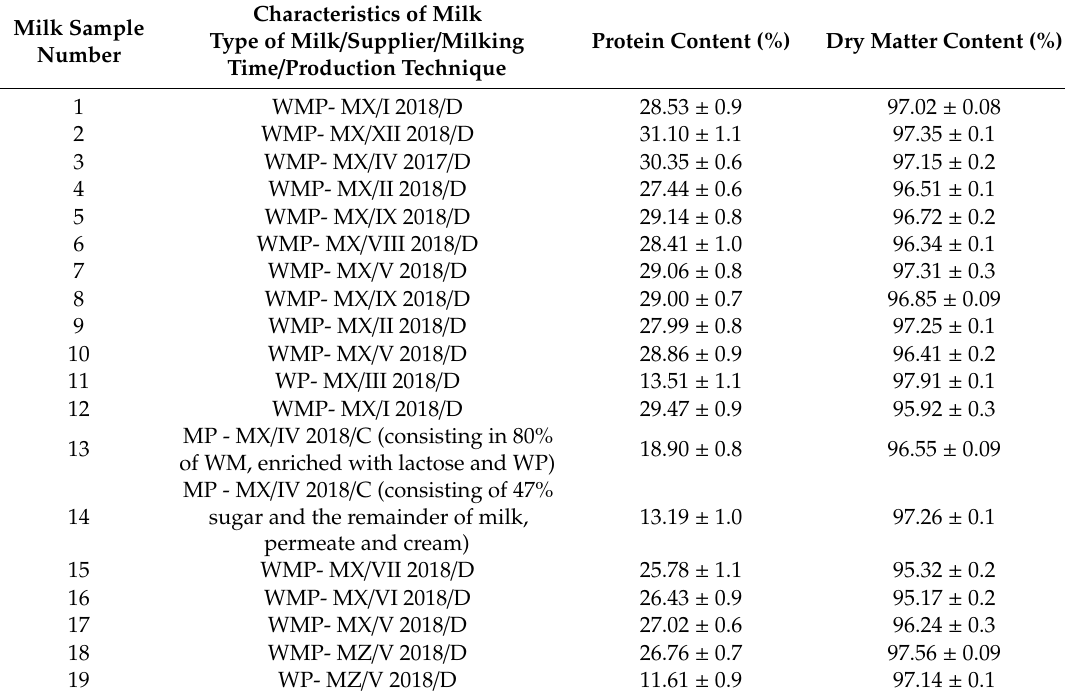
Table 1. Dry matter and protein content in milk powder